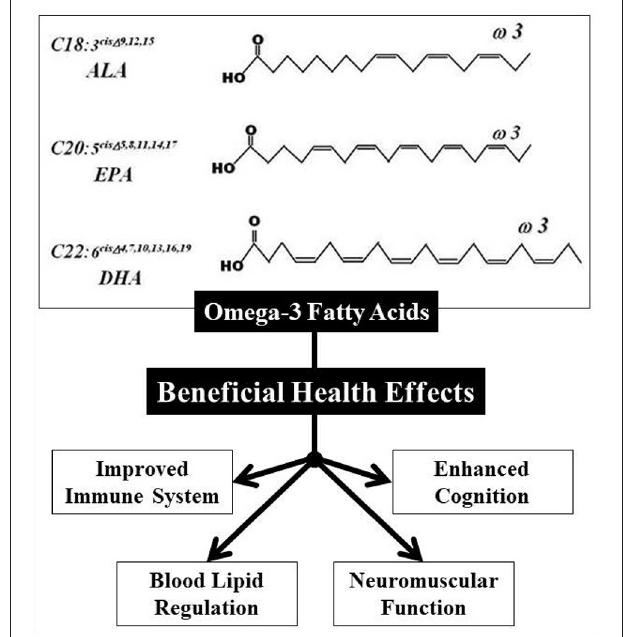
FIGURE 5 | Different health benefits of omega ( ω )-3 fatty acids in the human immune system ( 157–159).